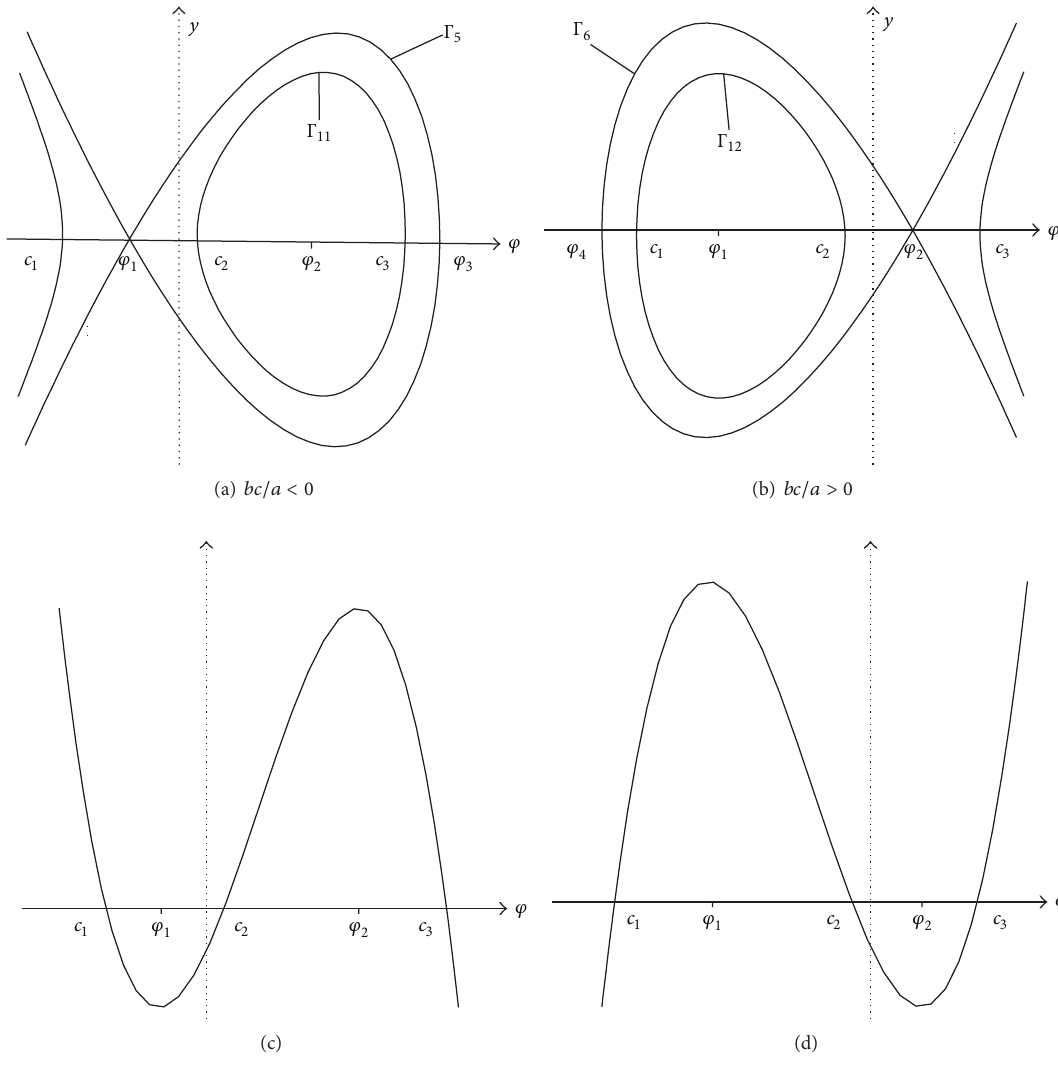
Figure 3: The bifurcation phase portraits of system (6) with 𝑔 ̸=0